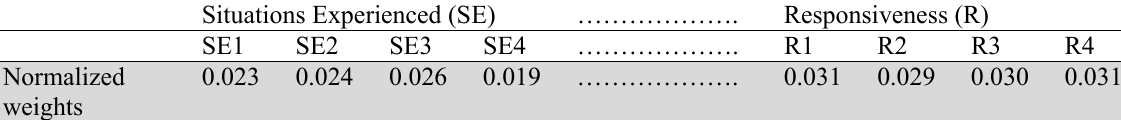
Normalized aggregated criteria importance weights Situations Experienced (SE)